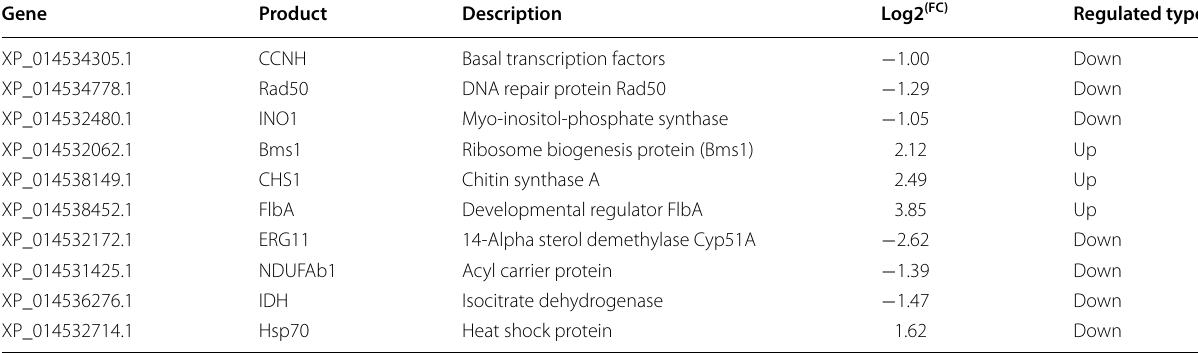
Table 4 RNA-seq analysis of ten genes mapped to the most enrichment pathways Gene Product Description Log2 (FC) Regulated type XP_014534305.1 CCNH Basal transcription